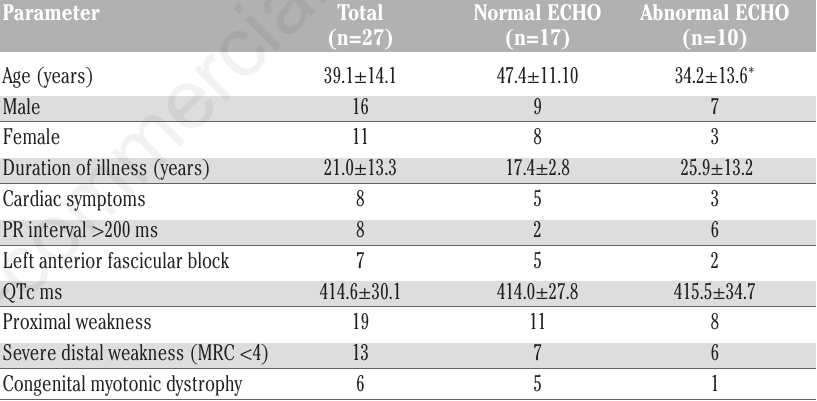
Table 1. Comparison of clinical and electrocardiographic findings in myotonic dystrophy type 1 patients with normal and abnormal echocardiogram.